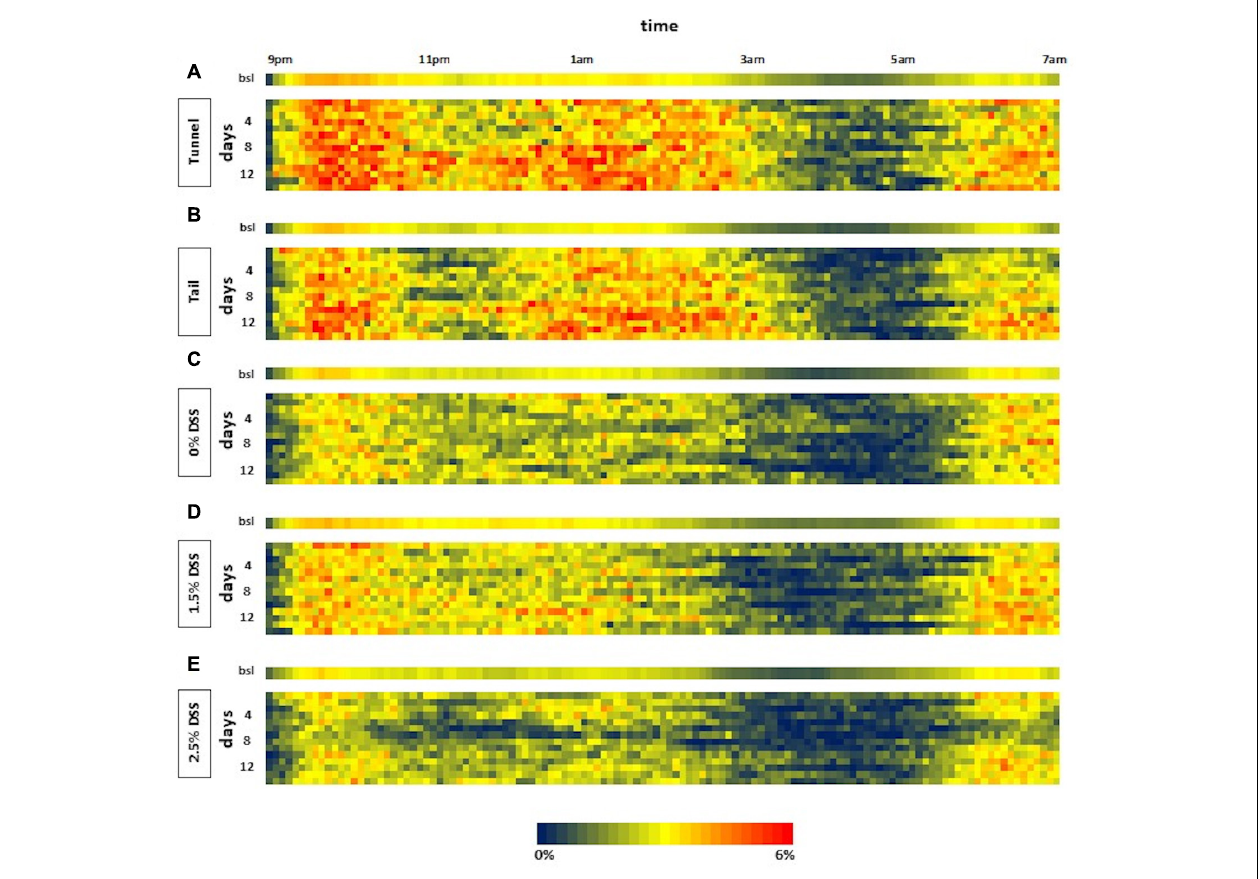
FIGURE 3 | Heat maps of the dark phase from days 1 to 14 of the three DSS groups and the two handling groups. The heat map shows the activity data displayed in 5-min intervals during lights-off for days of bsl and during the experiment (days 1–14). Each line represents one dark phase (9 p.m. to 7 a.m.). The values are color-coded with blue representing low and red representing high activity (0–6%). (A) Tunnel; (B) Tail; (C) 0% DSS; (D) 1.5% DSS; (E) 2.5% DSS; n = 5 cages each